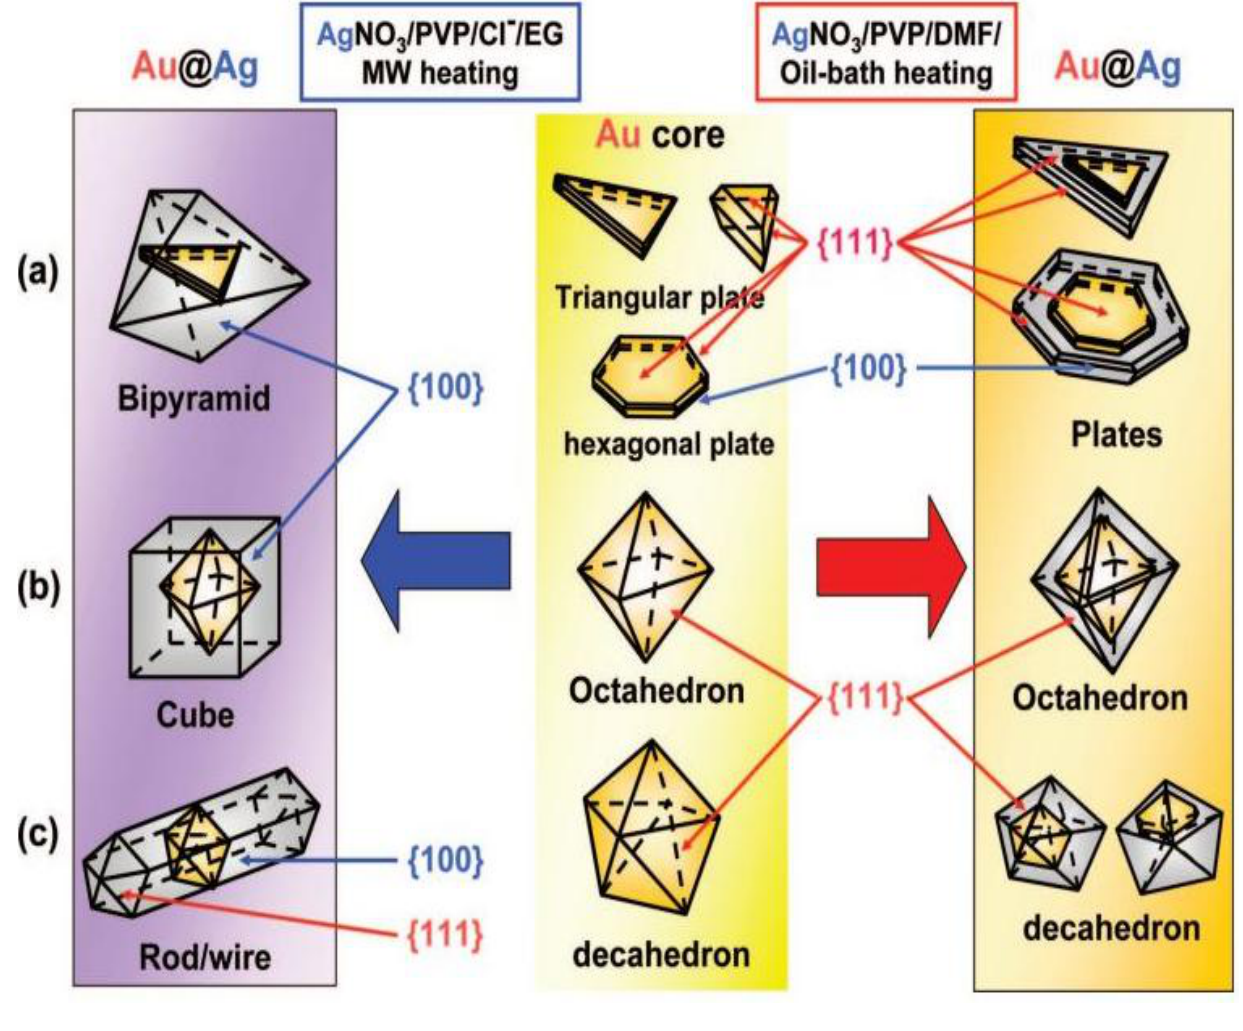
Figure 11. Schematic crystal structures of the Au cores and Au@Ag nanocrystals prepared in DMF by an oil-bath heating (right side) and in EG by a MW heating (left side) (reprinted with permission from [94]. Copyright (2008) American Chemical